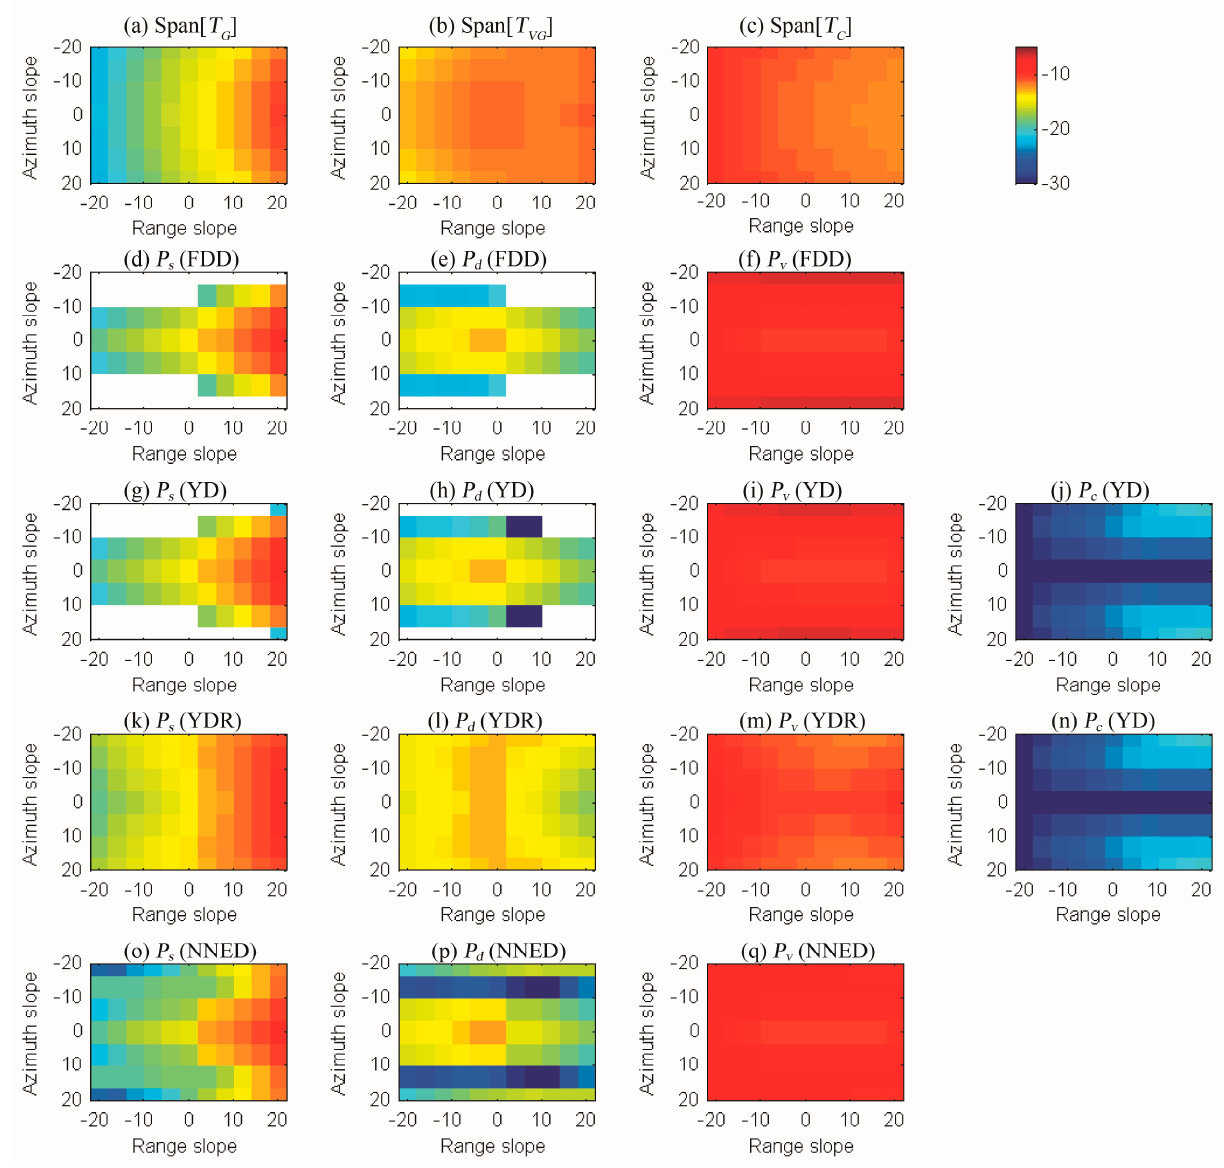
Figure 3. Changes in the scattering mechanisms with respect to the terrain range and azimuth slopes for S3. ( a – c ) Reference scattering mechanisms (ground, vegetation-ground and canopy scattering, respectively) of the simulated coherency matrix. ( d – f ) Calculated scattering components from the FDD method. ( g – j ) Calculated scattering components from the YD method. ( k – n ) Calculated scattering components from the YDR method. ( o – q ) Calculated scattering components from the NNED